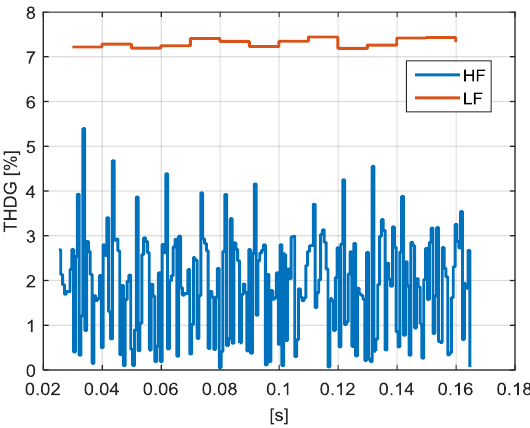
Figure 44. Case study 2: THDG at low-frequency (0 ÷ 2 kHz, red line) and at high-frequency (2 ÷ 150 kHz, blue line).